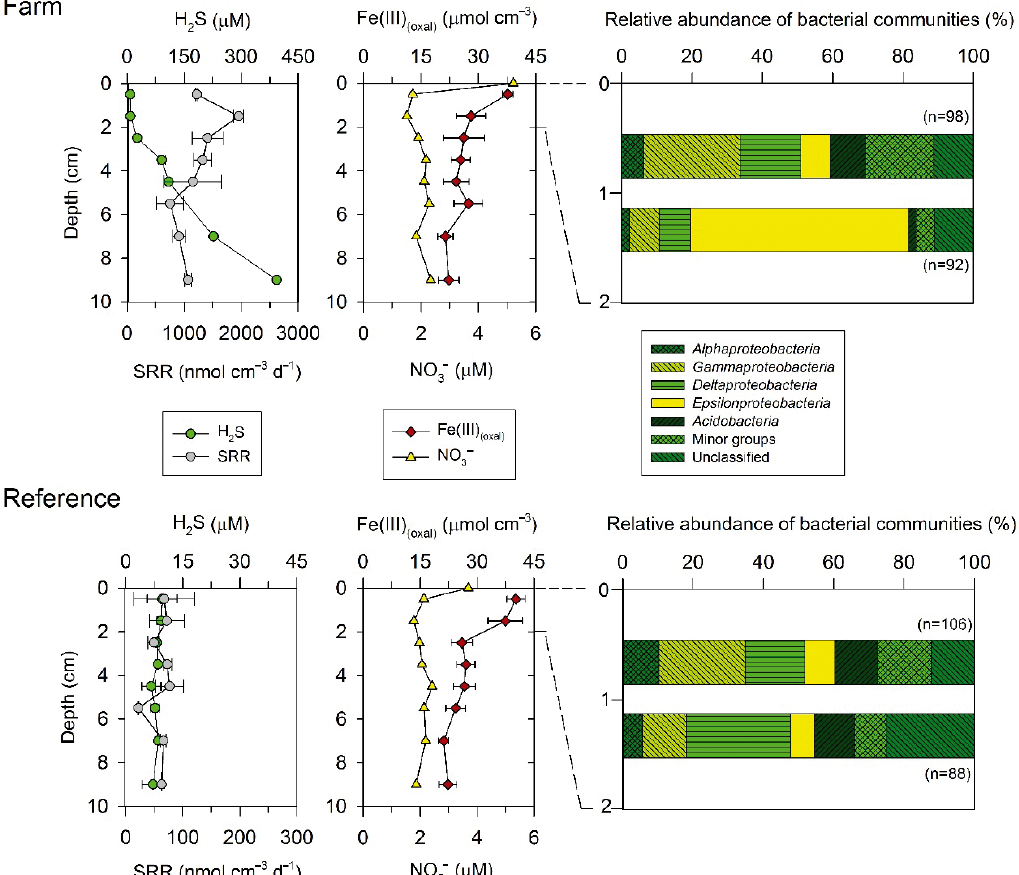
Fig. 6. Relative abundance of bacterial communities based on the 16S rRNA gene in the surface sediments (0−2 cm) associated with the vertical distribution of H 2 S, NO 3− , Fe(III) (oxal) and sulfate reduction rates (SRR). Bar represents the percentage of clone library composition represented by each group at the farm and reference